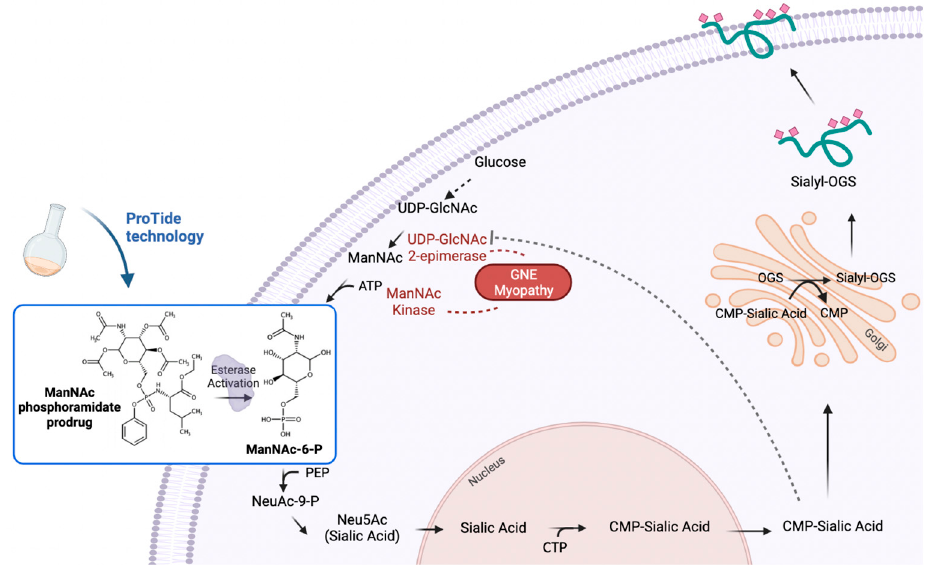
Figure 10. Schematic representation of the proposed therapeutic strategy by ManNAc phosphoramidate prodrugs in sialic acid biosynthetic pathway.